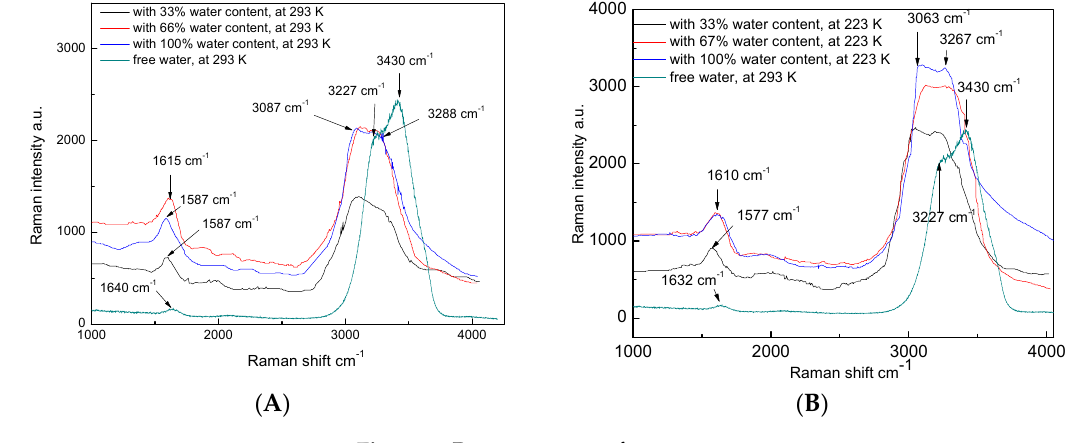
Figure 2. Raman spectra of pore water. Table 2. Raman shift of DDAA (double donor–double acceptor) and DA (single donor–single acceptor) in pore water with 100% pore filling.